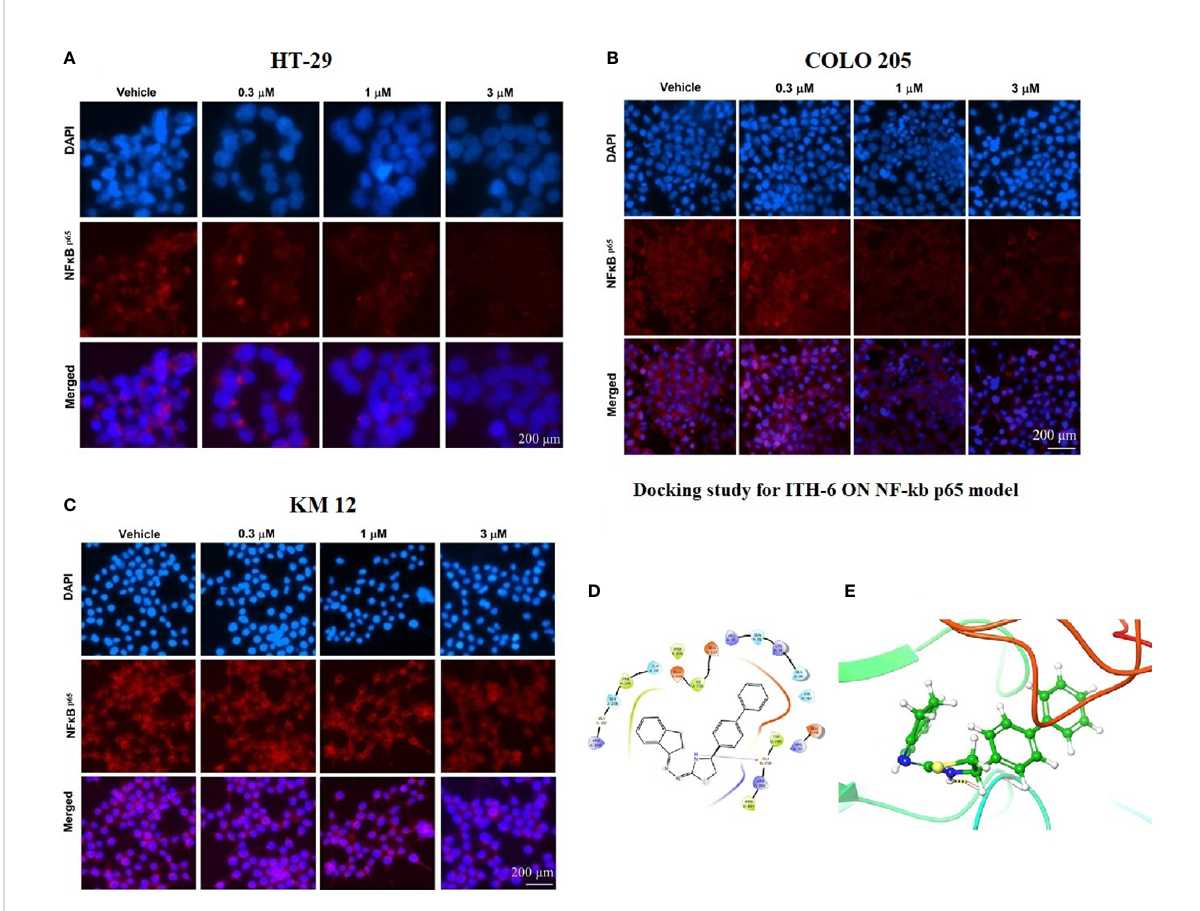
FIGURE 6 The effect of ITH-6 on the expression of NF- k B p65. (A) HT-29, (B) COLO 205, and (C) KM 12 cells were incubated for 72 hours with 0.3, 1, and 3 µM of ITH-6. The red color represents the presence of NF- k B p65, and the blue color represents the nucleus. (D) Docking pose of ITH-6 within the binding pocket of IkB a /NF- k B heterodimer. The protein is represented as multicolored ribbons. Amino acid residues are shown as follows: nitrogen in blue, hydrogen in white, carbon in gray, and oxygen in red. The ligand is represented by the ball and stick model with carbon atoms represented as carbon in green, nitrogen in blue, hydrogen in white, and sulfur in yellow. The yellow dashes represent the hydrogen bonding. (E) 2-D ligand interaction between ITH-6 and the IkB a /NF- k B heterodimer. Magenta arrow represents hydrogen bonding with amino acid residues within 5 Å of the